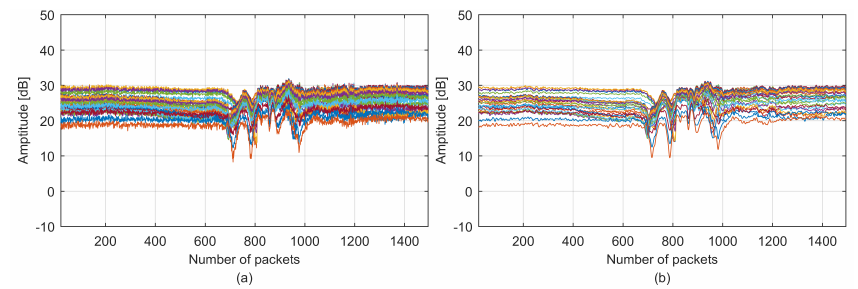
Figure 4. The CSI stream: ( a ) raw stream; ( b ) denoised stream.